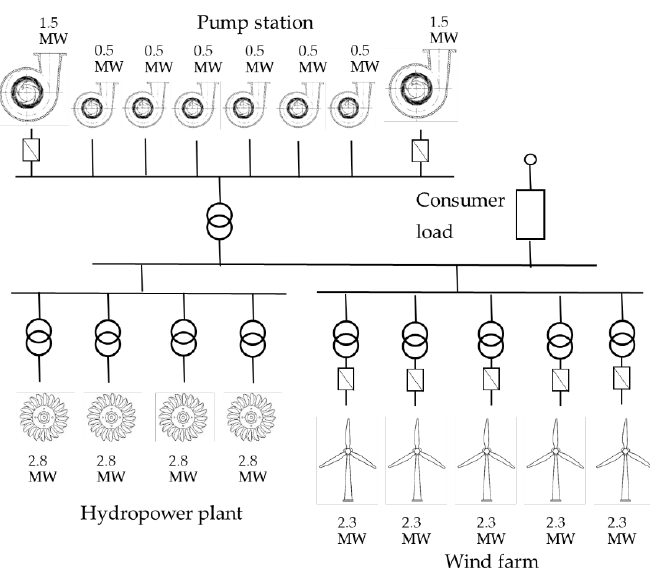
Figure 1. El Hierro hybrid wind pumped-storage hydropower plant (W-PSHP) system.